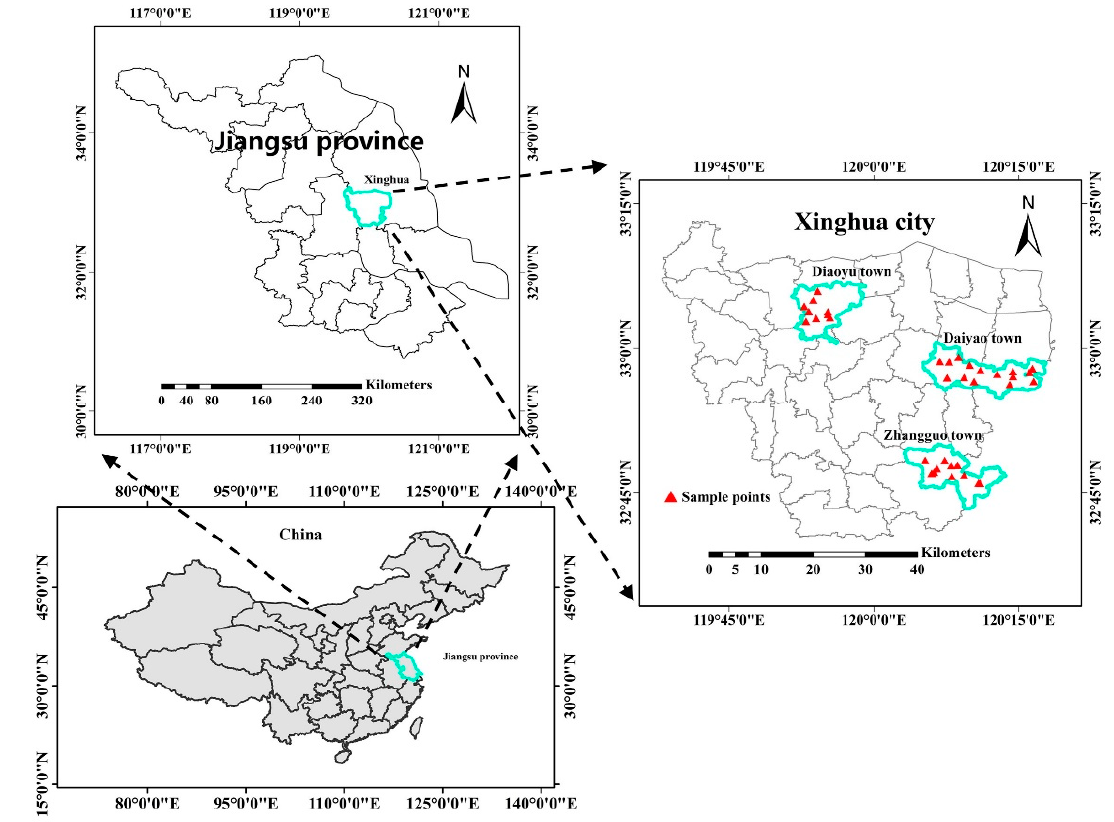
Figure 1. The distribution of sample fields in Xinghua city, Jiangsu Province, China.